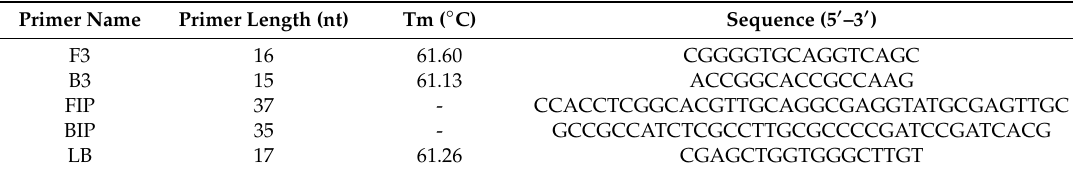
Table 2. Loop-mediated isothermal amplification (LAMP)